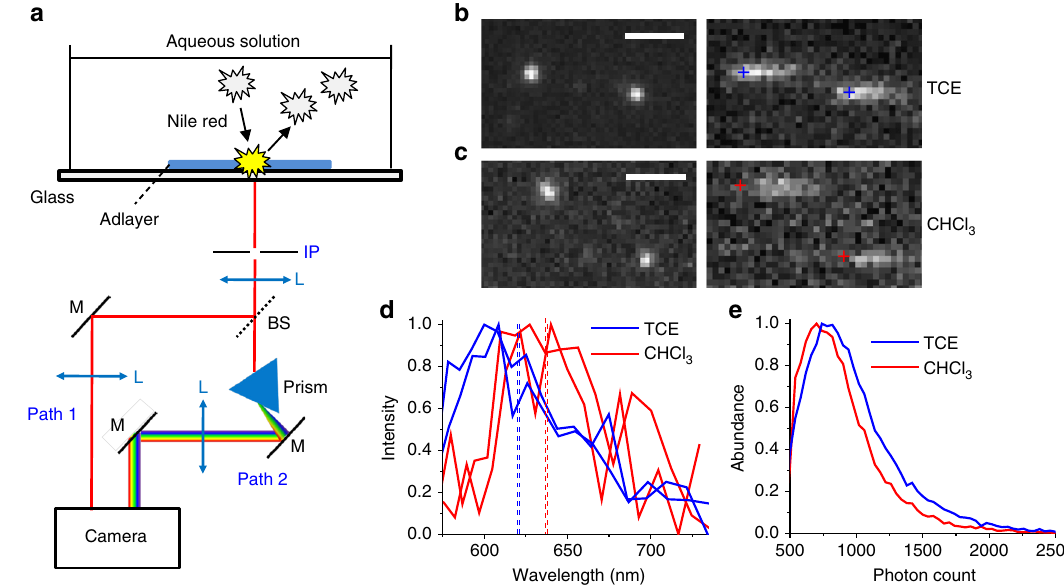
Fig. 1 Spectrally resolved super-resolution microscopy of small-molecule adlayers. a Experimental setup. The stochastic insertion of individual Nile red molecules from an aqueous solution into the TIR-illuminated adlayers leads to bursts of single-molecule fl uorescence, which is split into two light paths for concurrent recording of the position (Path 1) and the spectrum (Path 2) of each molecule in the wide fi eld. IP: intermediate image plane, L: lens, BS: beam splitter, M: mirror. b A small region of the concurrently acquired images (left) and spectra (right) of two single Nile red molecules inserted into TCE adlayers, obtained in a 9-ms snapshot. Crosses indicate the mapped spectral positions of 590 nm for each molecule. Scale bar is 2 μ m. c Results of chloroform adlayers. Scale bar is 2 μ m. d Spectra of the four single molecules in b , c . Dash lines give the spectral mean of each spectrum. e Distribution of photon counts in the image channel for single Nile red molecules in typical data of TCE (blue; average is 984 photons) and chloroform (red; average is 896 photons)